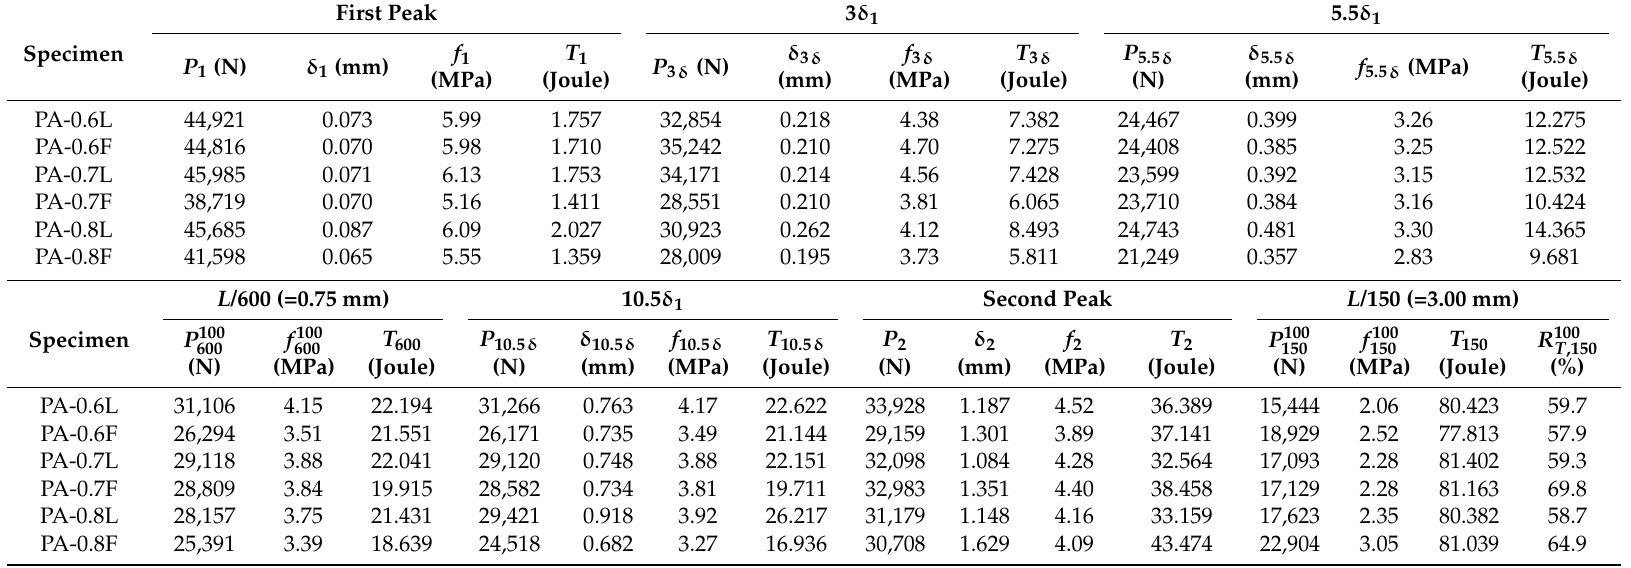
Table 7. Average value of flexural responses of